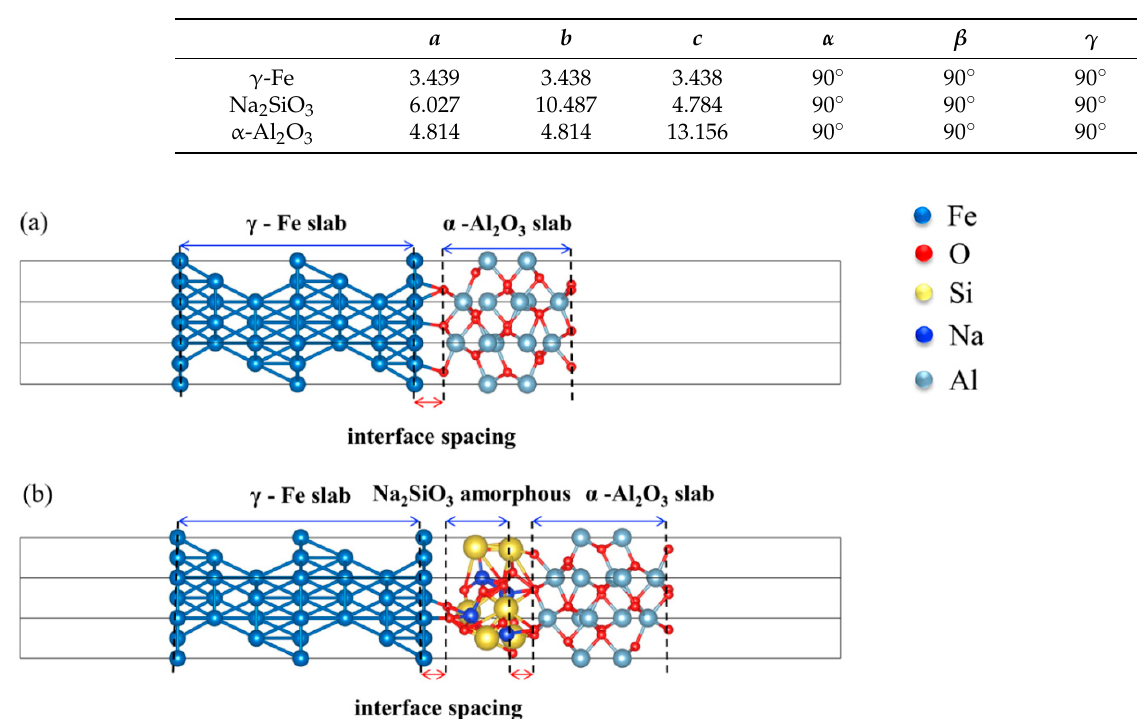
Figure 2. The model of the ( a ) Fe-Al 2 O 3 and ( b ) Fe-amorphous Na 2 SiO 3 -Al 2 O 3 interfaces.